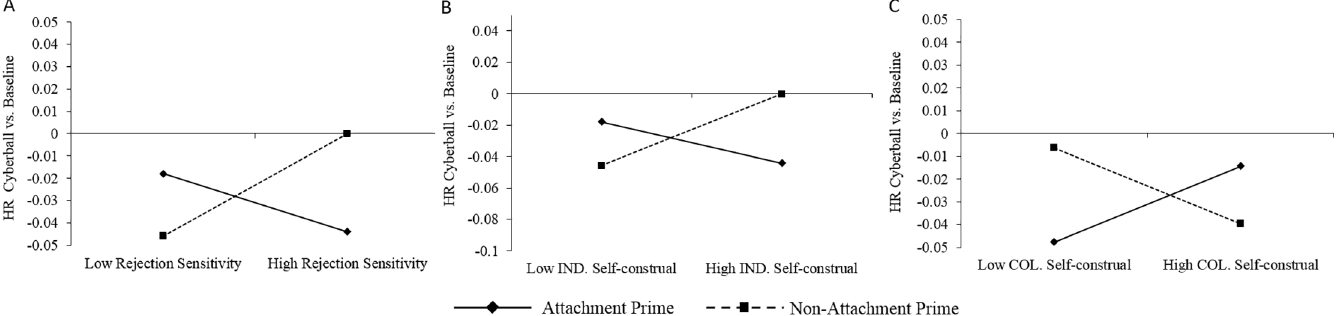
Fig 2. Simple slopes analyses for heart rate changes relative to baseline during Cyberball. (2A). Rejection Sensitivity; (2B) Individualistic (IND) Self-construal; (2C) Collectivistic (COL) Self-construal.